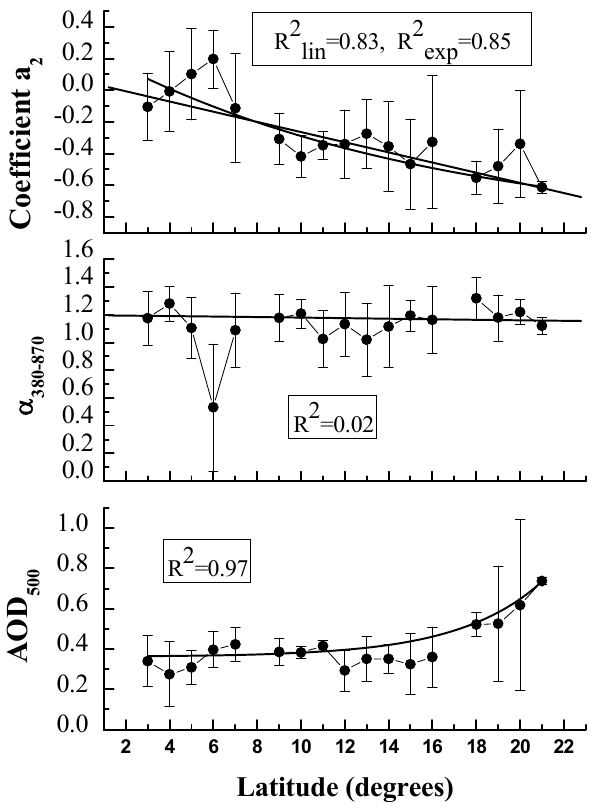
Fig. 5. Mean latitudinal variation of AOD 500 , α 380 − 870 and coefficient a 2 over BoB during W-ICARB. The linear and ex- ponential fits shown in the graph are: [AOD 500 = 0 . 36 + 0 . 001expˆ( x /3.79)], [ α 380 − 870 =− 0 . 002 x + 1 . 19], [ a 2 =− 0 . 03 x + 0 . 06], [ a 2 = − 0 . 91 x + 1 . 19expˆ( x /15.34)], where x is the latitude. The R 2 values of the fits are shown in each